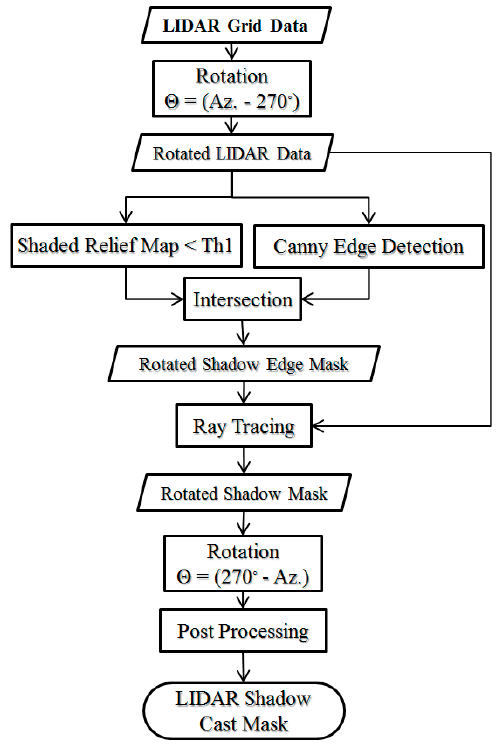
Figure 8. Flowchart of the shadow reconstruction from raster LiDAR data.